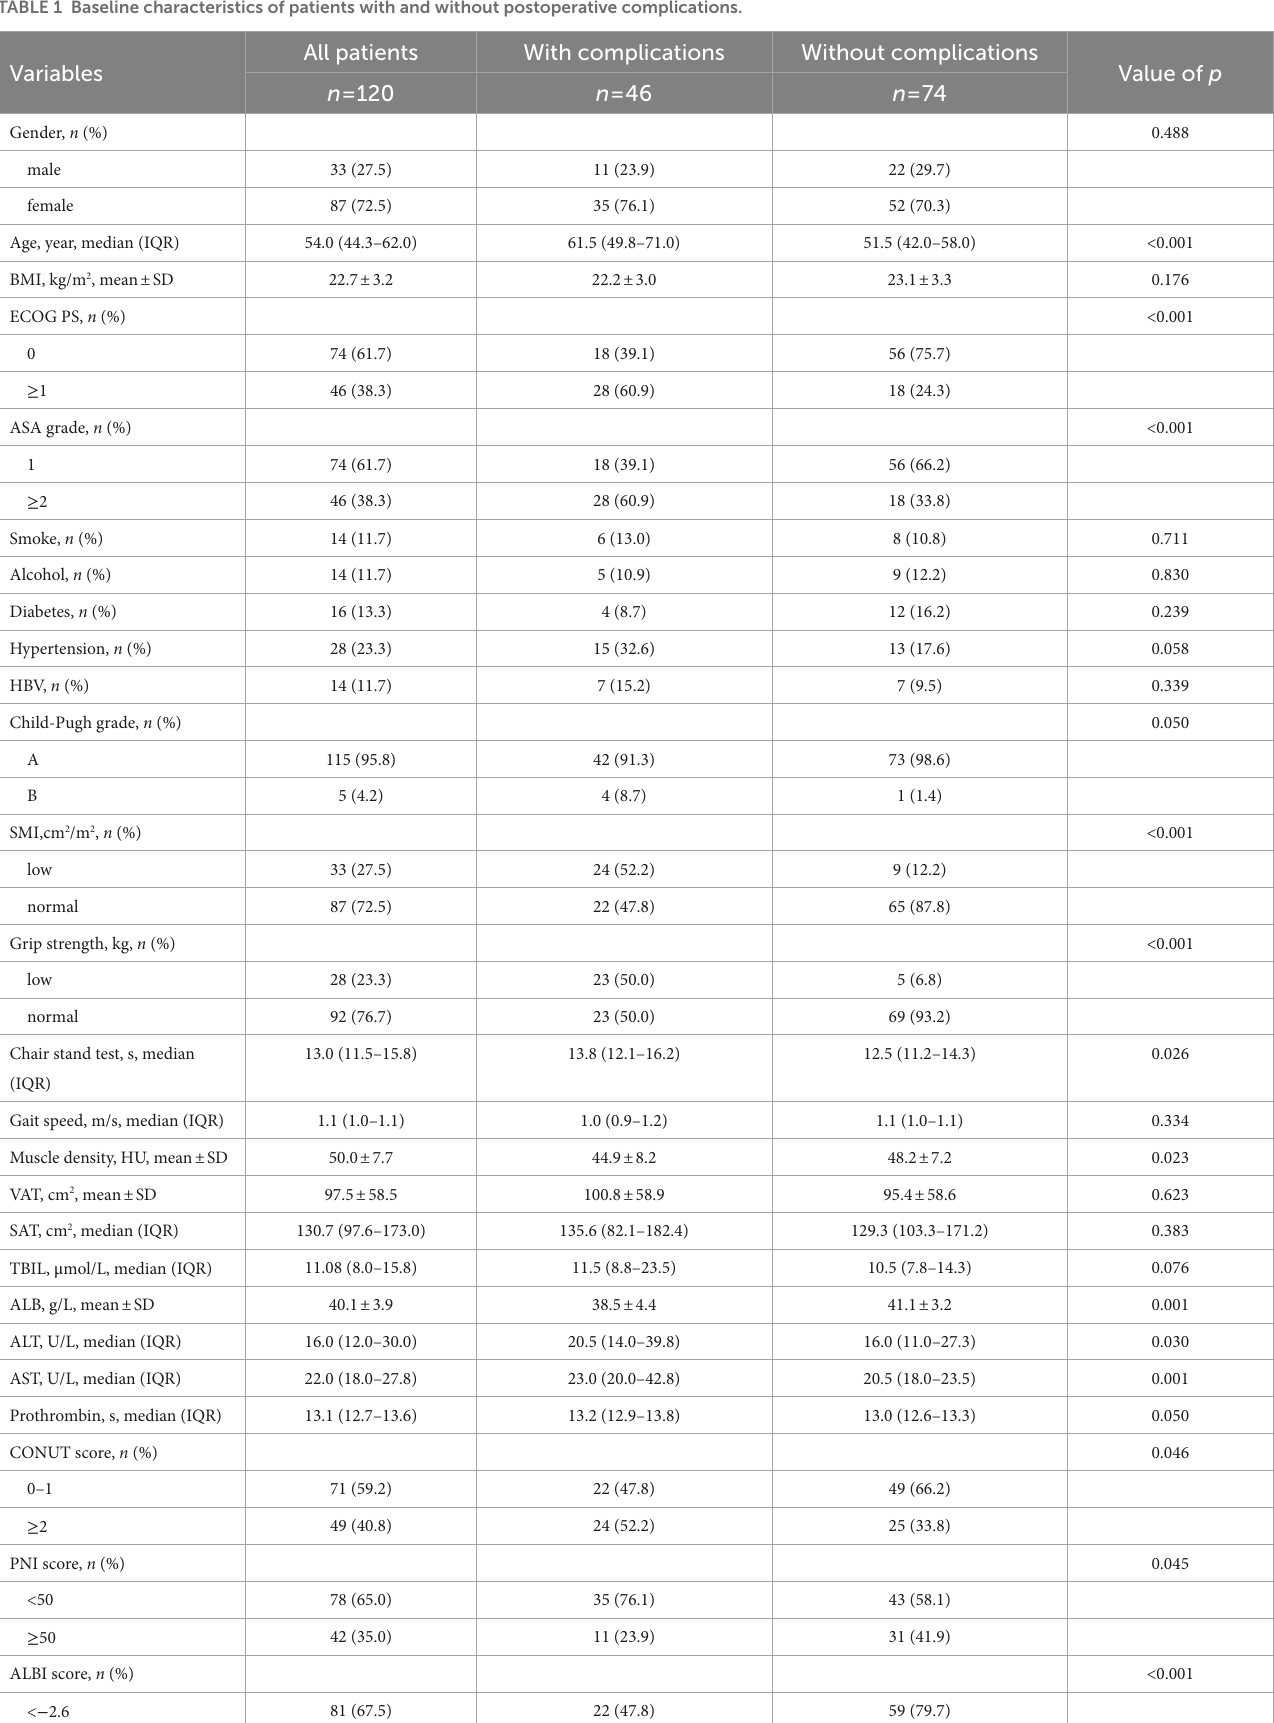
TABLE 1 Baseline characteristics of patients with and without postoperative complications. All Variables